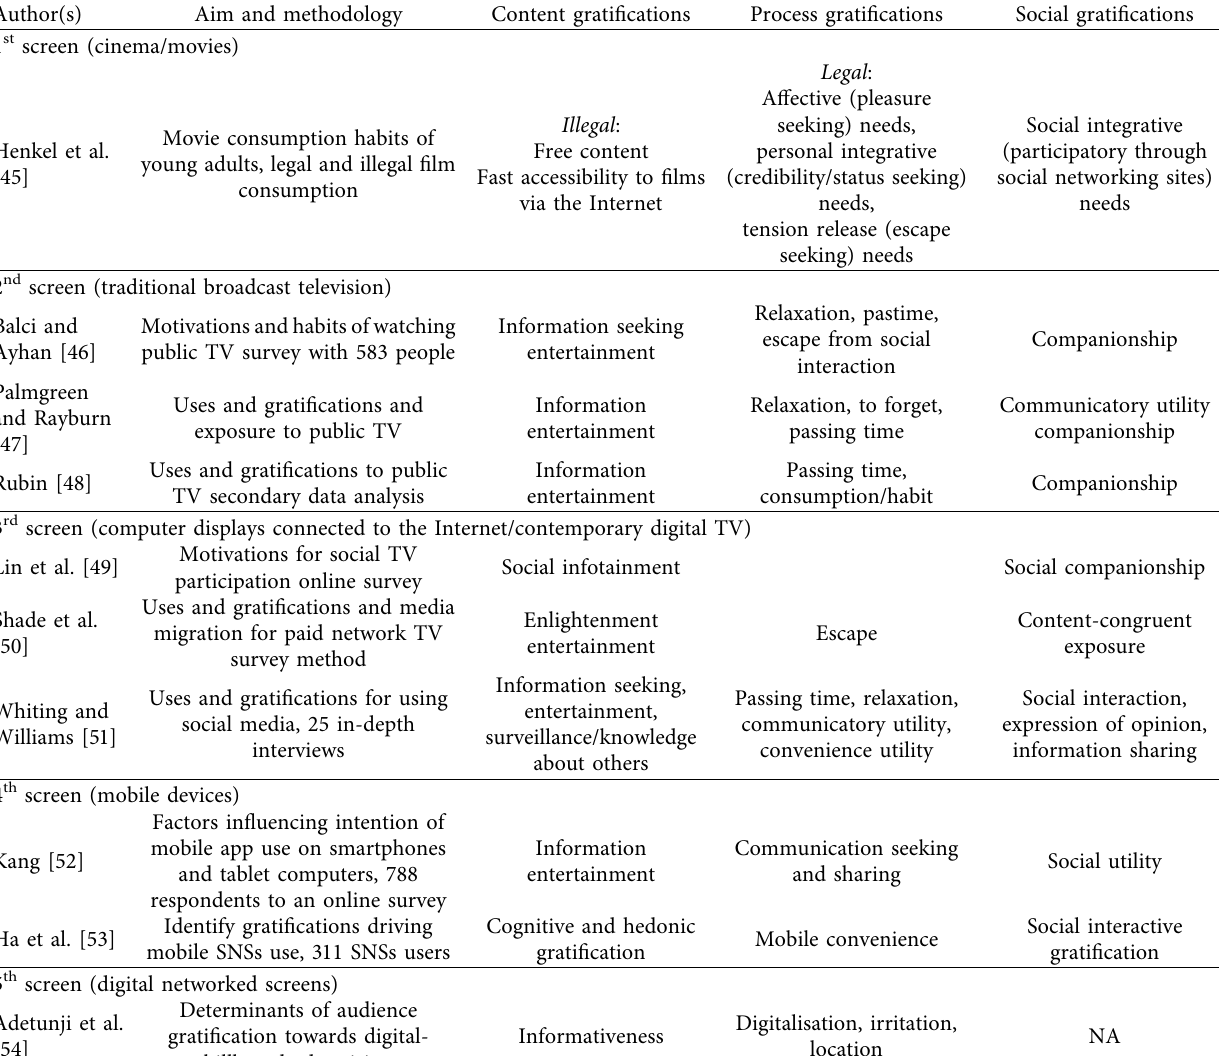
Table 1: Past U&G research on different media